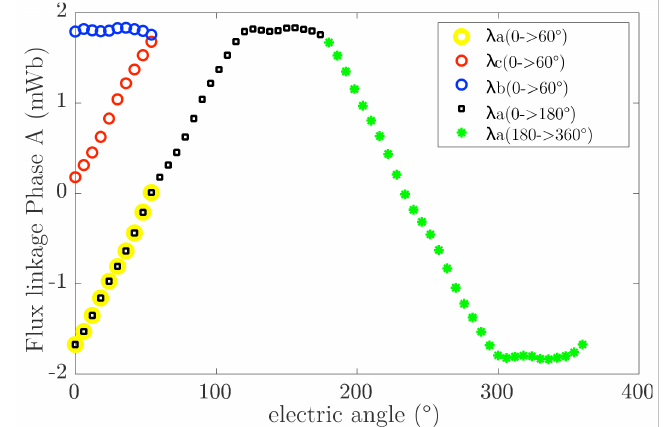
Figure 6. Flux linkages